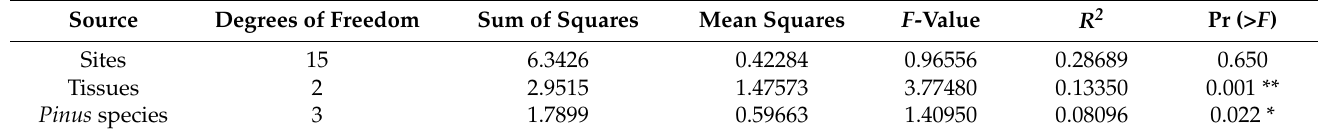
Table 1. Results of permutational multivariate analysis of variance (PERMANOVA) main test.